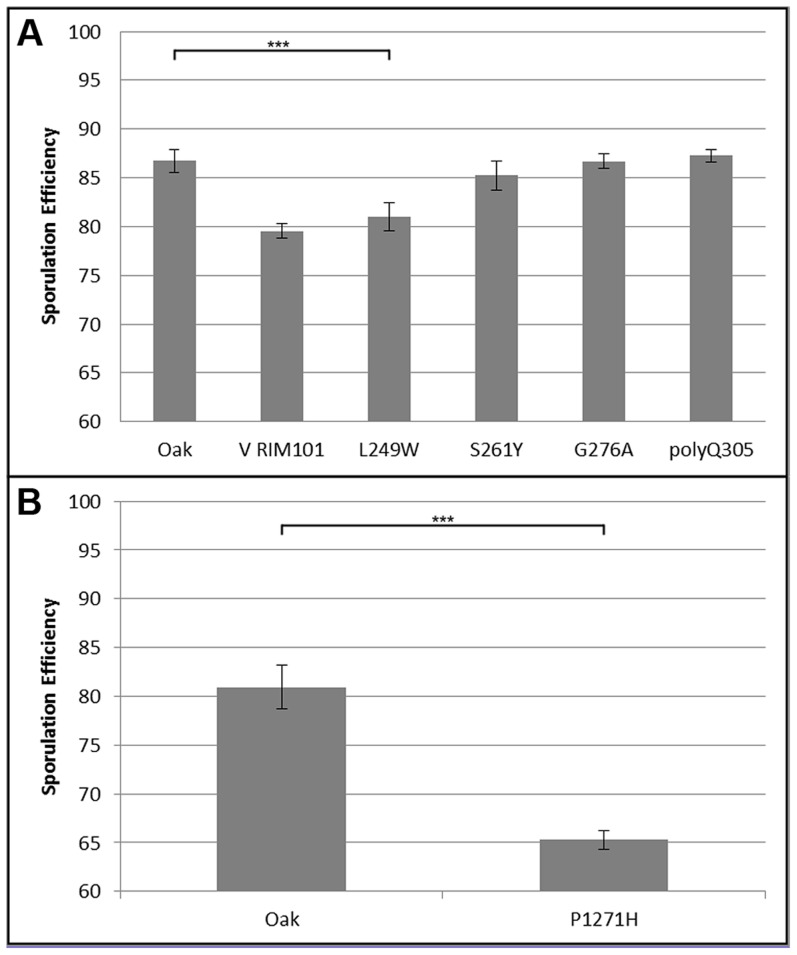
Single allele replacement analysis.All replacements were performed in the BC248 oak background. WT indicates unaltered oak strain. Error bars indicate standard deviation among at least 4 replicates (t-test, *** indicates P<0.001). A) RIM101 replacements. V RIM101 indicates the full (coding and noncoding) RIM101 gene was replaced with the M5 vineyard version; all other bars are single allele replacements as indicated. B) RIM15 single allele replacement.